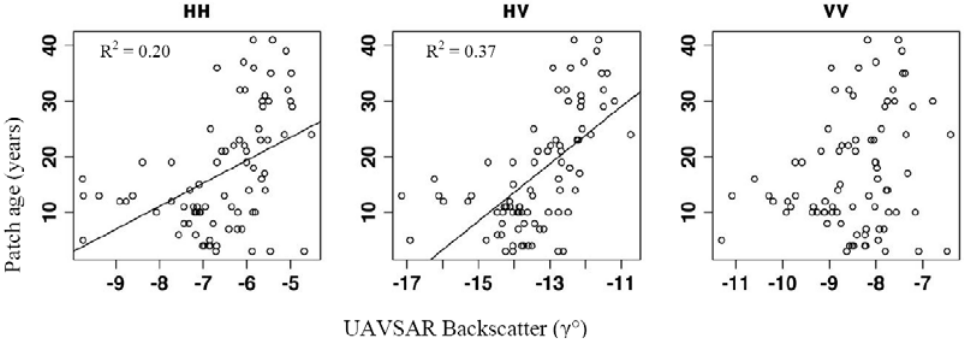
Figure 5. Forest patch age modeled as a function of UAVSAR calibrated backscatter. Gridded 5 m resolution γ ° values were averaged for each patch. Overlap with UAVSAR swath is >5 ha. Line fits are added to significant models (Table